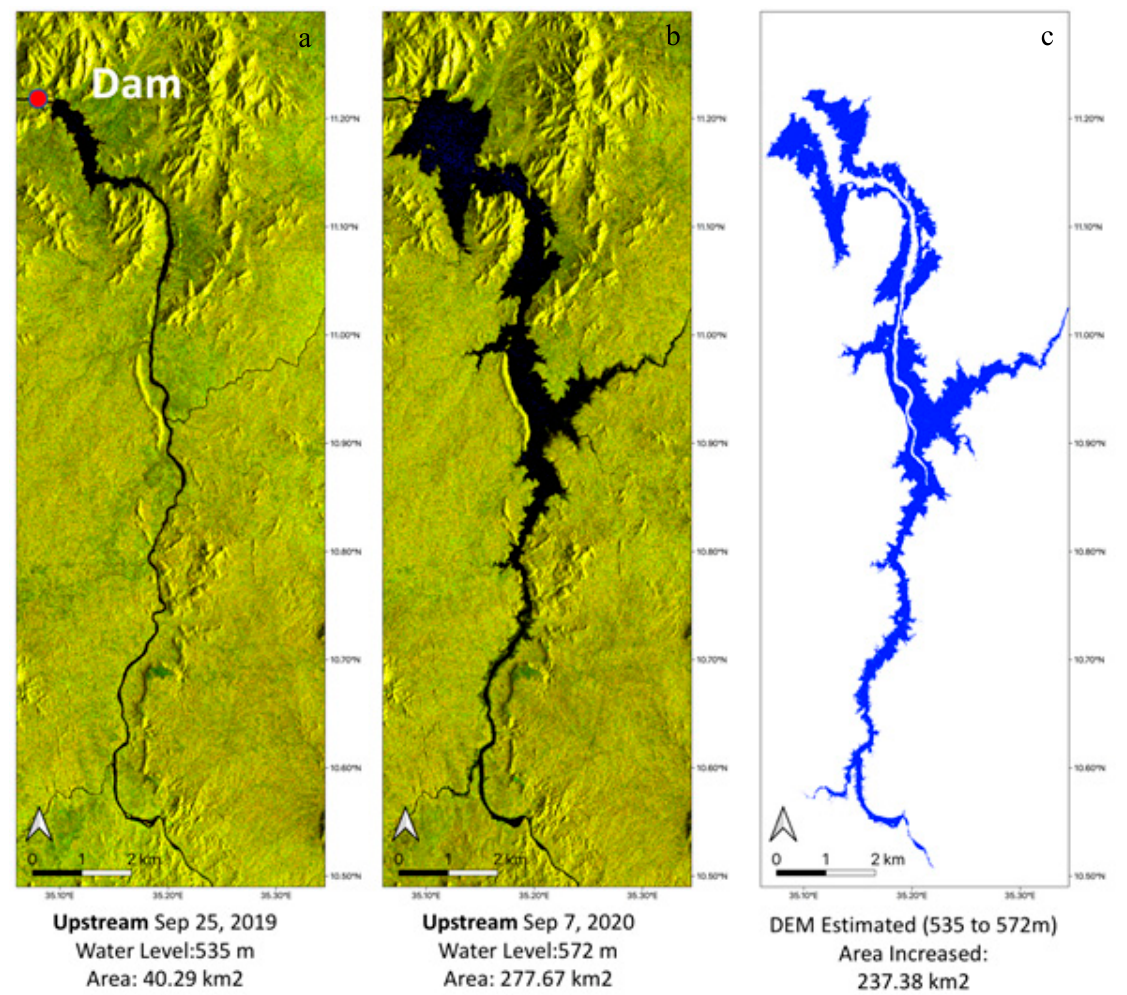
Figure 3. ( a–c ) Composite Sentinel-1 images that highlight the spatial extent of the Millennium Reservoir before and after the filling process started. Figure (c) depicts the total extent of increased reservoir area as obtained from the digital elevation model (DEM). Table 1. Water level estimated from the DEM and corresponding volume of the reservoir.